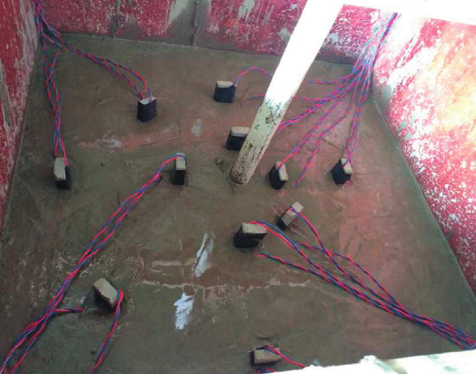
Figure 13: The experimental test block